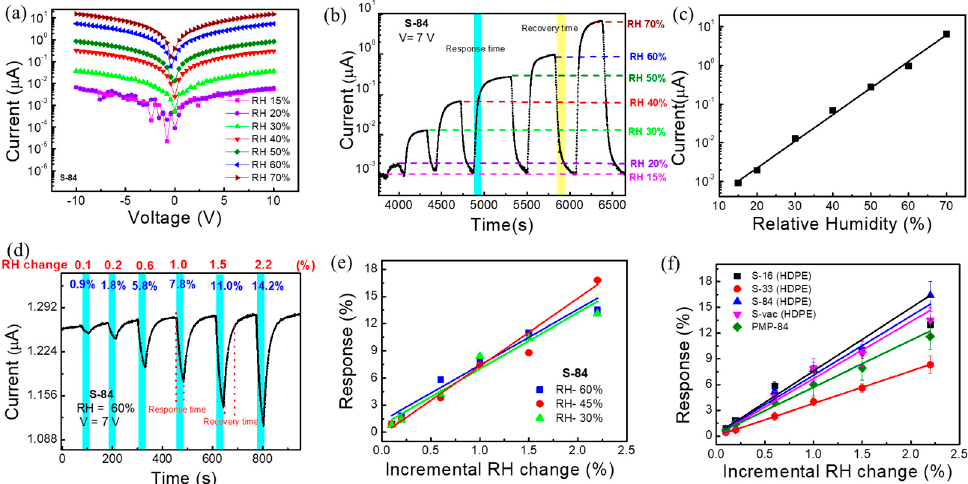
Figure 4. ( a ) I-V characteristic plot of SnO 2 -based sensor S − 84 under different relative humidities. ( b ) Current–time measurement curve of S − 84 under different relative humidities. ( c ) Calibration curve of relative humidity response under different RH. ( d ) The incremental change response under 60% RH. ( e ) Incremental change response vs. low-level RH change data plot under different relative humidities of S − 84 . ( f ) Calibration curve of incremental change response under low-level RH change for different samples S − 16 , S − 33 , S-84, S − vac, and PMP − 84 . The wide-dynamic-range responses to relative humidity, RH (%), of 20%, 30%, 40%, 50%, 60%, and 70% are plotted in the current vs. time plot in Figure 4b. The measurement 15%. As mentioned before, increasing the relative humidity increases the current level. The response time, Rs T90 , (marked in cyan blue color) and the recovery time, Rc T90 , (marked in yellow color) of the proposed sensor are 90 s and 150 s, respectively. Here, T90